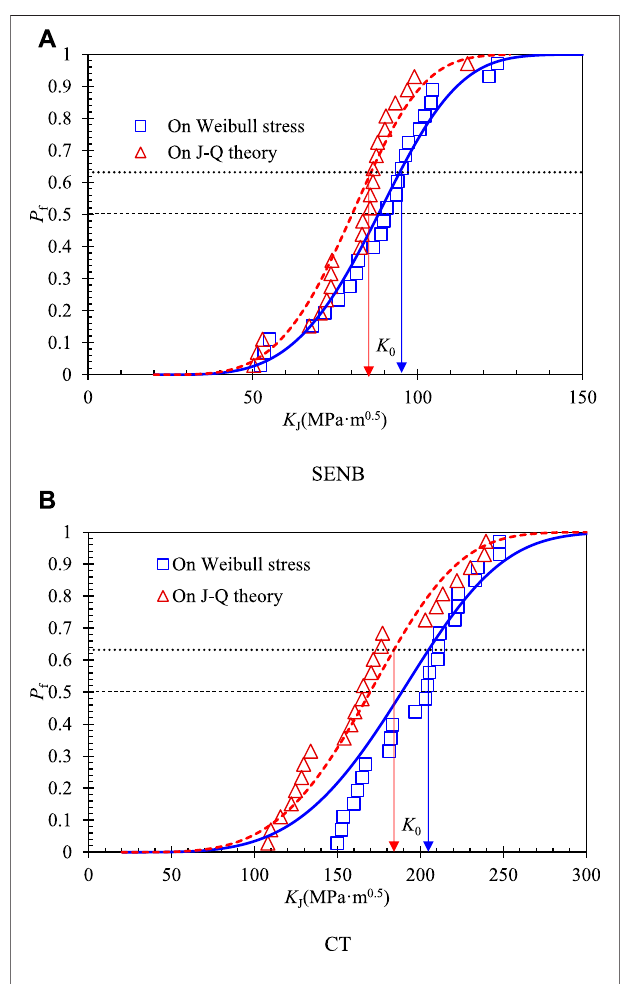
FIGURE 12 | Cumulative failure probability of the scaled toughness on the two approaches. (A) SENB. (B) CT.